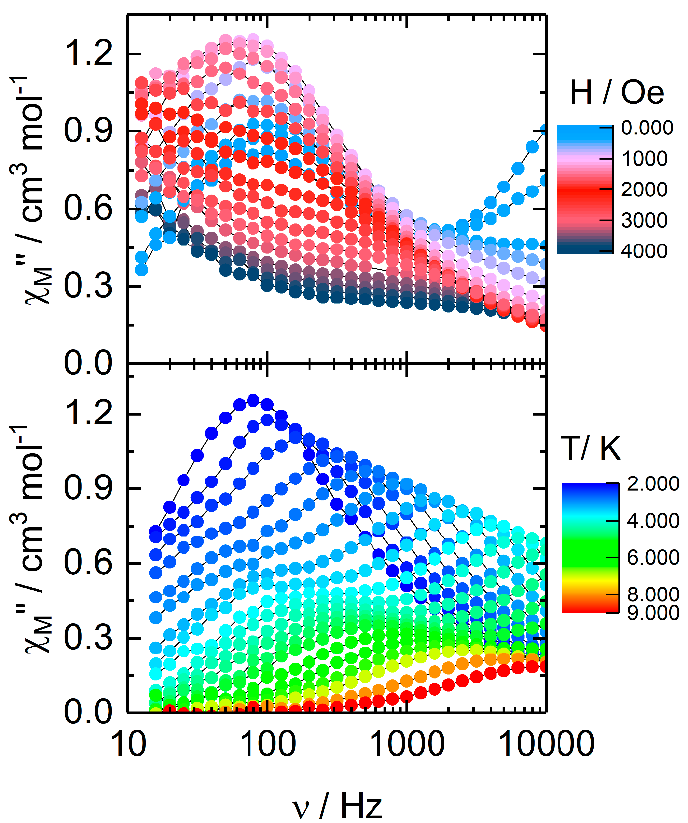
Figure 5. (Above) field dependence of the out-of-phase contribution of the magnetic susceptibility between 0 and 4000 Oe at 2 K for 2 . (Below) Frequency dependence of the out-of-phase contribution of the magnetic susceptibility between 2 and 9 K under an applied field of 1200 Oe. At 2 K, a single signal was observed centered at 80 Hz, while when increasing the temperature, a second contribution localized at a lower frequency appeared in the experi- mental frequency windows. The temperature dependence of the relaxation time for the two contributions of the magnetic susceptibility was extracted, fitting simultaneously χ M (cid:48) and χ M ” with a modified extended Debye model (Figure S14 and Table S5). The relaxation time of the magnetization ( τ ) for the two high frequency (HF) and low frequency (LF) contributions can be fitted using the thermally dependent Raman process only ( τ − 1 = CT n